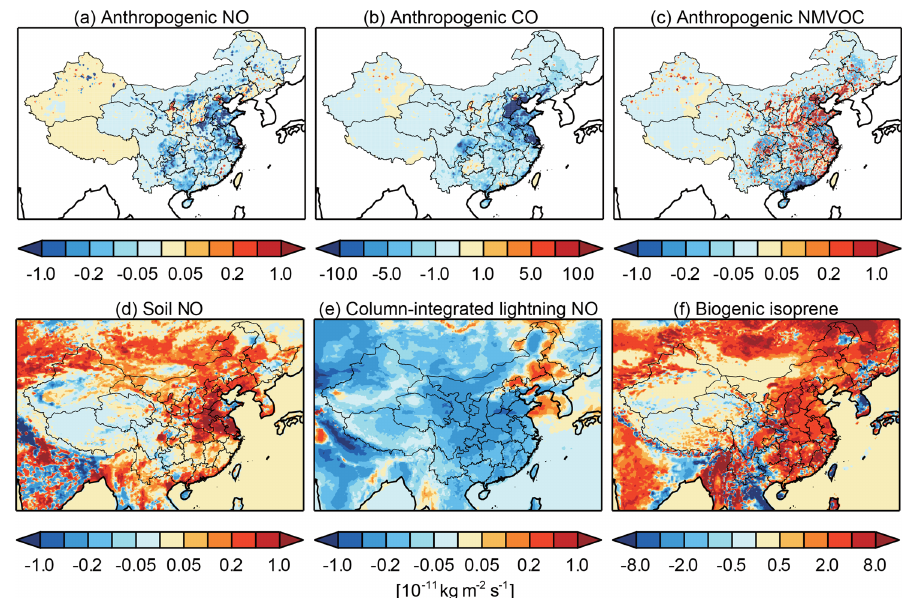
Figure 11. Differences in May–August mean (a) anthropogenic NO emissions, (b) anthropogenic CO emissions, (c) anthropogenic NMVOC emissions, (d) soil NO emissions, (e) column-integrated lightning NO emissions, and (f) biogenic isoprene emissions between 2017 and 2016 (2017 minus 2016 conditions).